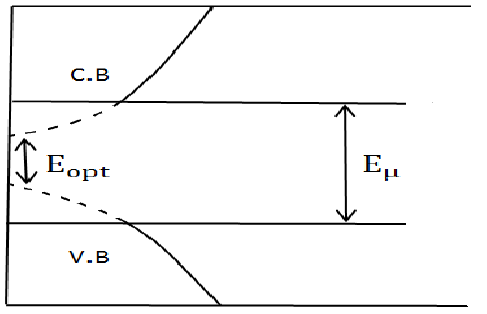
Fig. 2: The simplest interpretation of the meaning of the optical energy gap , where represents the mobility